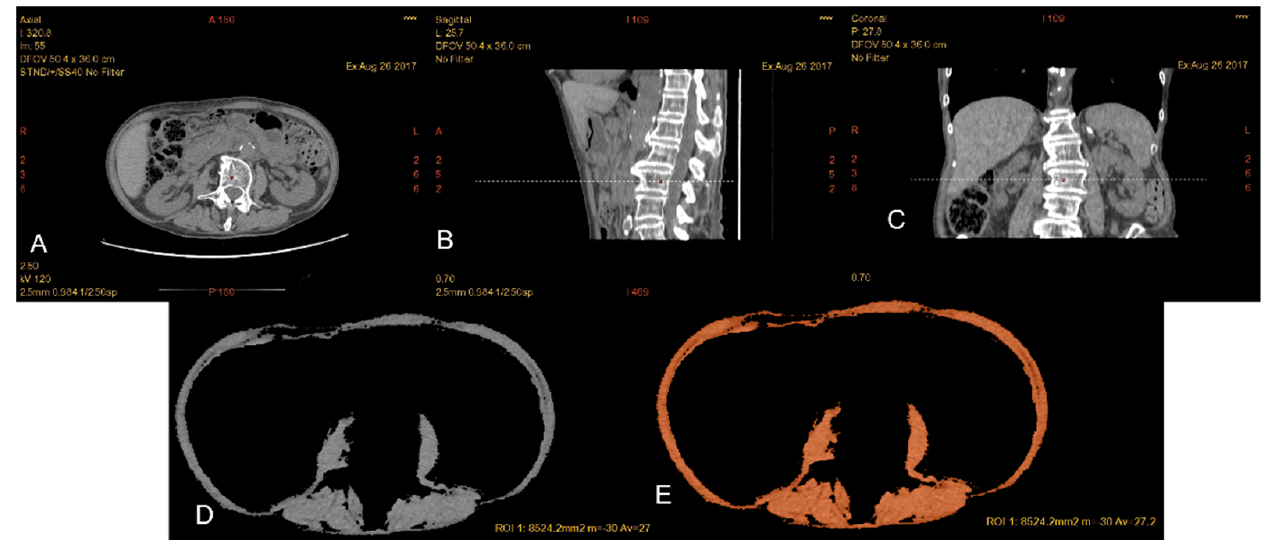
Figure 1. Patient with reduced muscle mass ( A – E ): in ( A ), axial CT image at the level of L3 as confirmed by the corresponding reference line in the sagittal ( B ) and coronal ( C ) planes. By applying the threshold − 29/+ 150 HU, it is possible to selectively choose the muscle component and draw a ROI including all the musculature at the level of L3 (TLA). Automatically, it is possible to read the overall value of the traced area in cm 2 and the average value of the